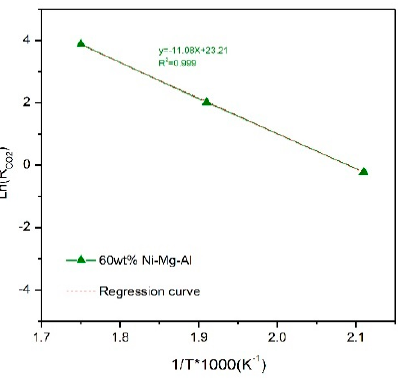
Figure 3. Arrhenius plot for CO 2 methanation over 60 wt% Ni-Mg-Al catalyst .